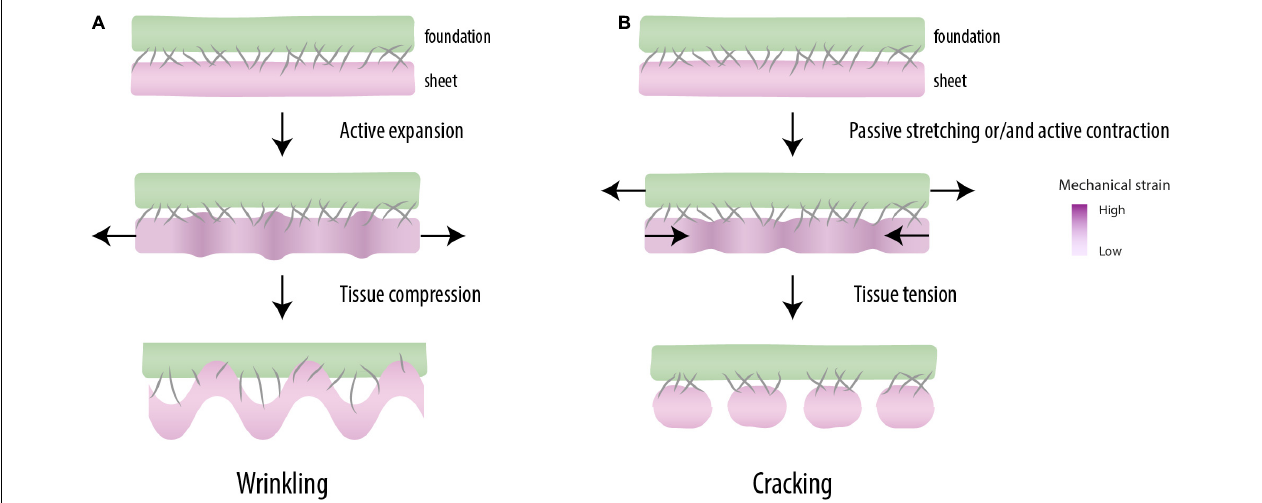
FIGURE 2 | Mechanical patterning. When mutually adherent tissues expand at different rates (top), a periodic pattern of differential strain capable of driving morphogenesis is created (middle). When the mechanical instabilities are created under compression, one of the tissues forms wrinkles, a characteristic feature of the morphogenesis of some organs (e.g., guts, brain) (bottom) (A) . Under tension, these instabilities break up the tissue into regular pieces (cracking), as observed in somitogenesis (bottom) (B)